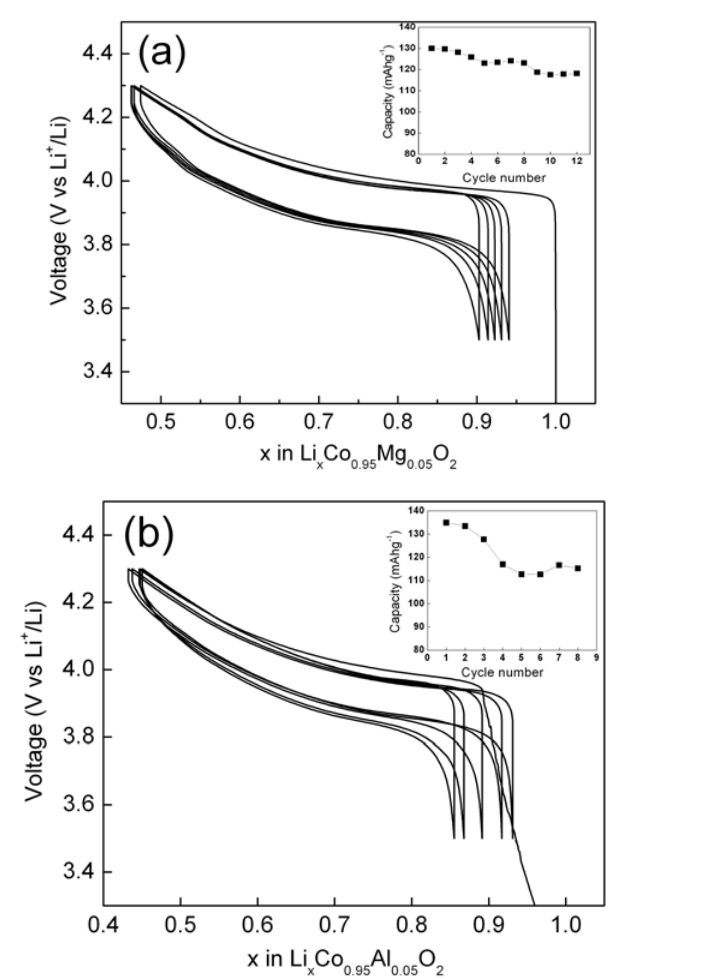
The voltage versus composition curves for (a) Li/LiCo (b) Li/LiCo Al O cells in the voltage window 3.5-4.3 V. Corresponding capacity 0.95 0.05 2 versus cycle number data are shown as